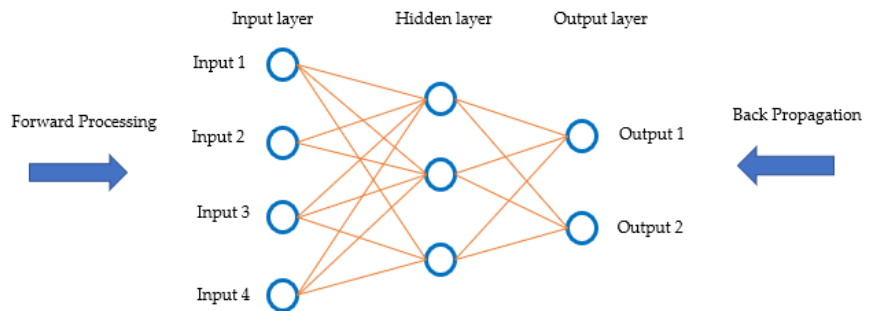
Figure 5. Architectural graph of a multi-layer perceptron with one hidden layer. Source: Authors’ elaboration based on Haykin (2009, p. 124).